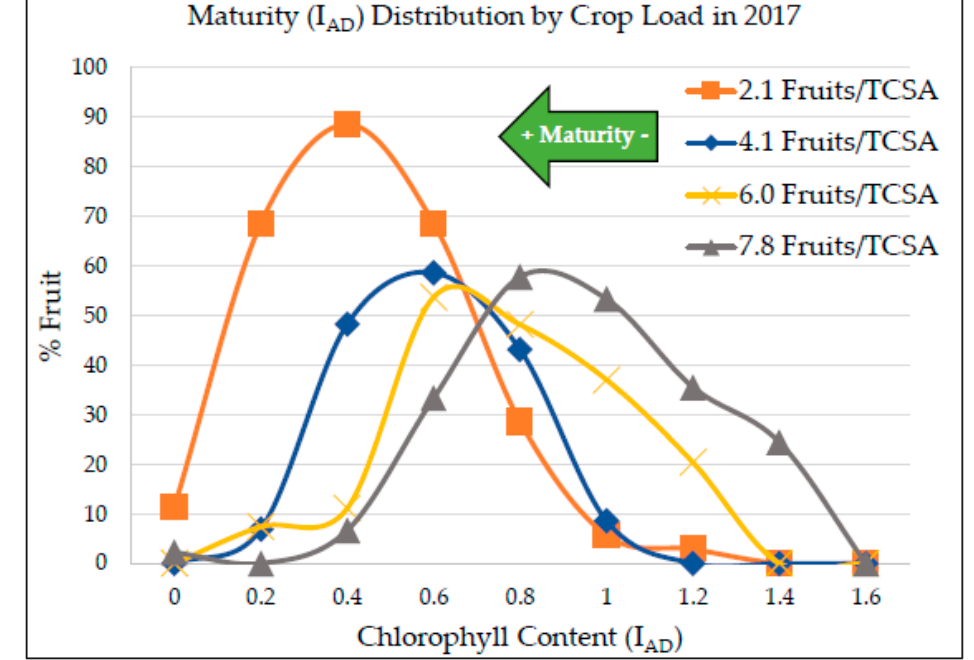
Figure 3. Distribution (% fruit) of index of absorbance difference (I AD ) measurements by DA meter [35] for “WA38” apples grown in the different crop load (2.1, 4.1, 6.0, 7.8 fruits/cm 2 ) levels observed immediately after harvest (no storage) in Washington State, Wenatchee area in 2017.